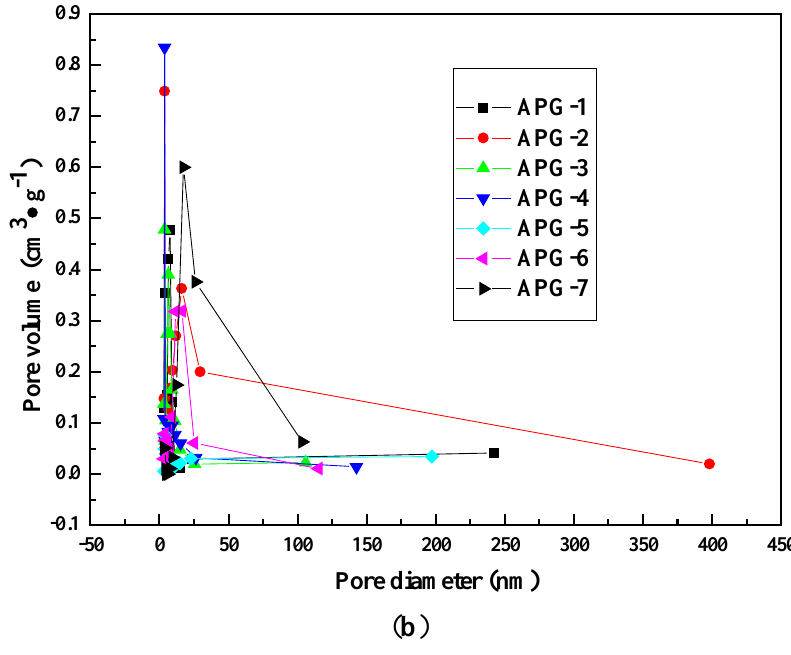
Figure 1. N 2 adsorption isotherms and pore size distribution of sulfur transfer catalysts with different metals. ( a ) Adsorption and desorption curves; ( b ) Pore size distribution diagram. Table 1. Pore parameters of different sulfur transfer